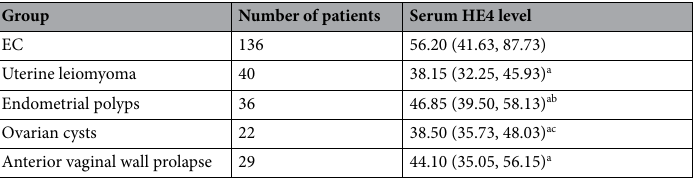
Table 2. Serum HE4 levels in different groups (mean (Q25, Q75)). EC endometrial cancer. a A significant difference compared with the EC group. b A significant difference compared with the uterine leiomyoma group. c A significant difference compared with the endometrial polyp group. d A significant difference compared with the ovarian cyst